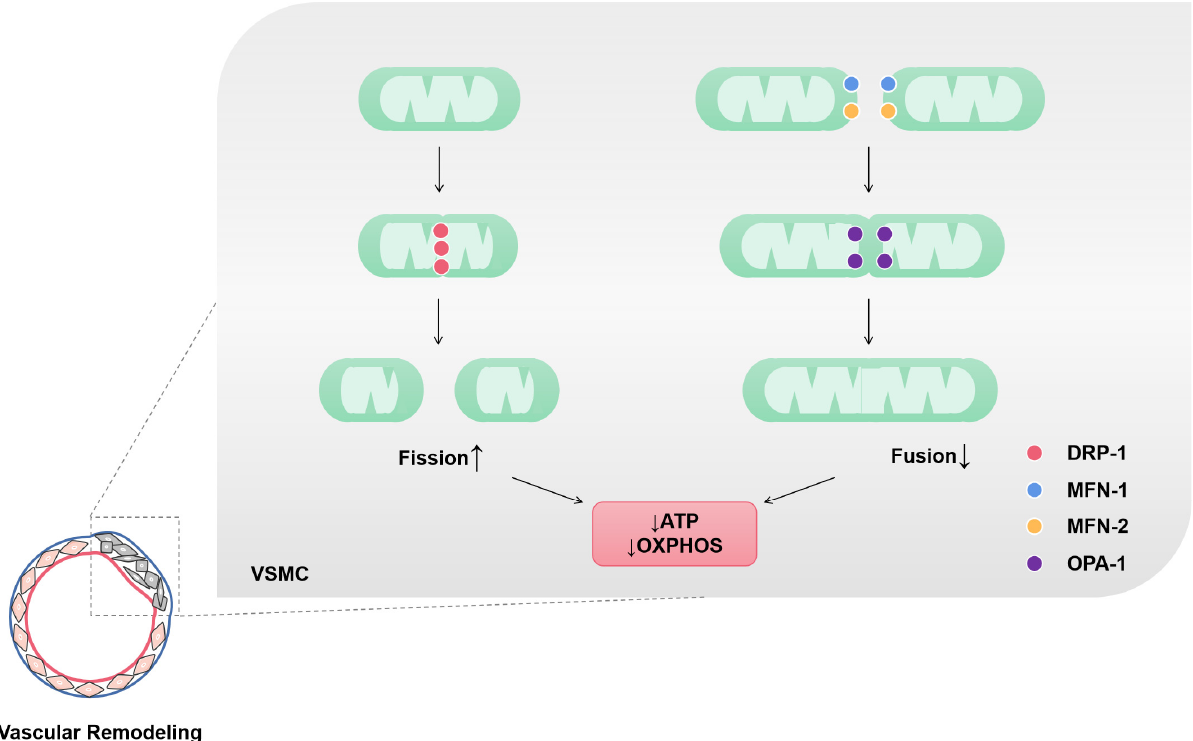
Figure 2. Mitochondrial fission and fusion of VSMCs in vascular remodeling. Mitochondria in vascular remodeling are characterized by increased fission and reduced fusion. Dynamin-related protein-1 (DRP-1) is a GTP hydrolase (GTPase) that initiates fission. Mitochondrial fission is associated with ATP production and O 2 consumption decrease. Mitofusin-1 and 2 (MFN-1 and MFN-2) are GTPases in the outer mitochondrial membrane (OMM). These two enzymes mediate the fusion of OMM adjacent mitochondria. Optic atrophy protein-1 (OPA-1) is a dynamin-related protein localized in the inner mitochondrial membrane (IMM) that participates in the fusion of IMM. Mitochondrial fusion is associated with an increase in ATP production and